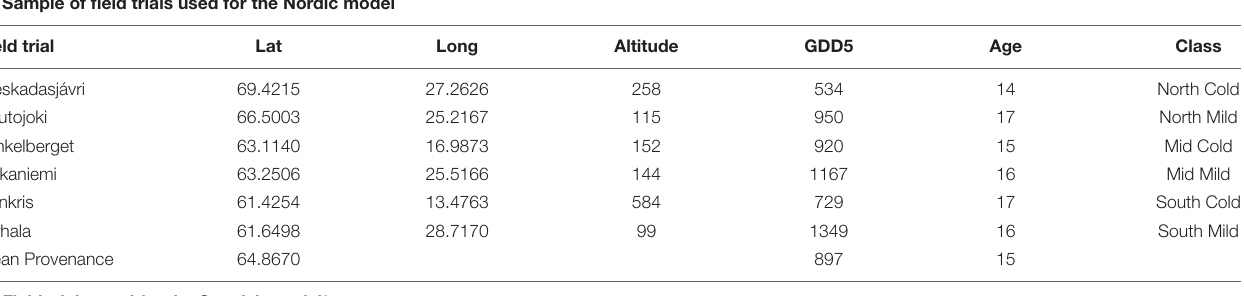
(A) Sample of field trials used for the Nordic model Field trial Lat Long Altitude GDD5 Age Class ˇCieskadasjávri